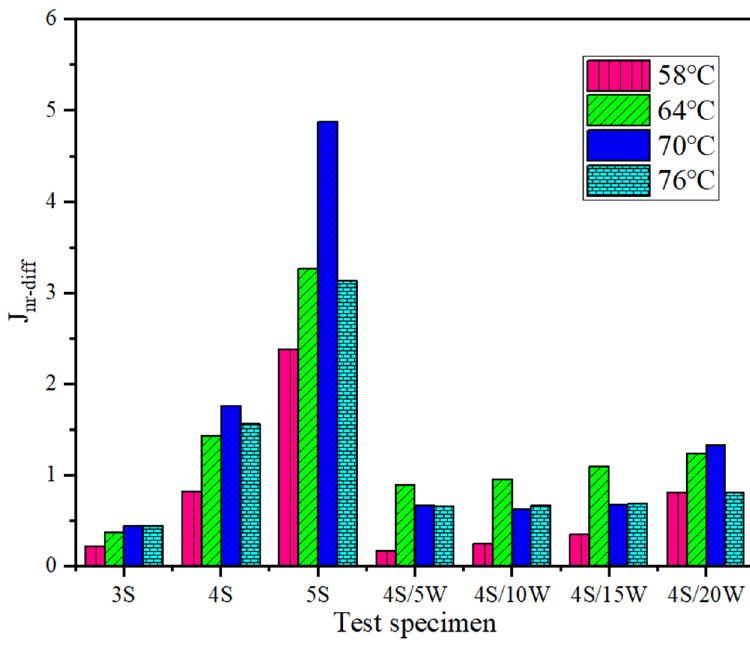
Figure 9. J nr-diff of WPU/SBS composite modified asphalt.